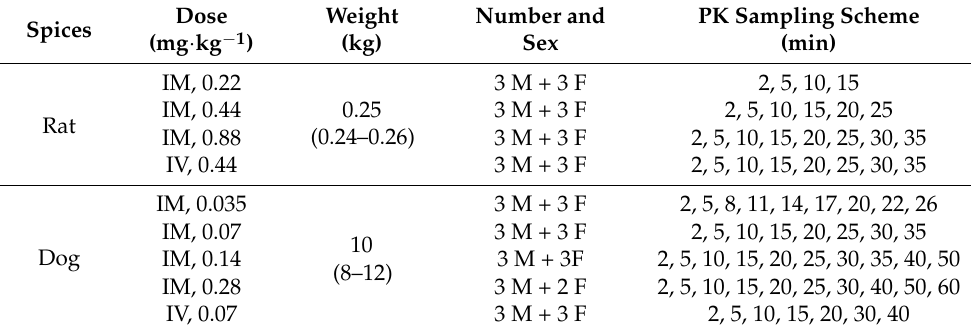
Table 1. Results of pharmacokinetic studies of GeXIVA[1,2] in rats and